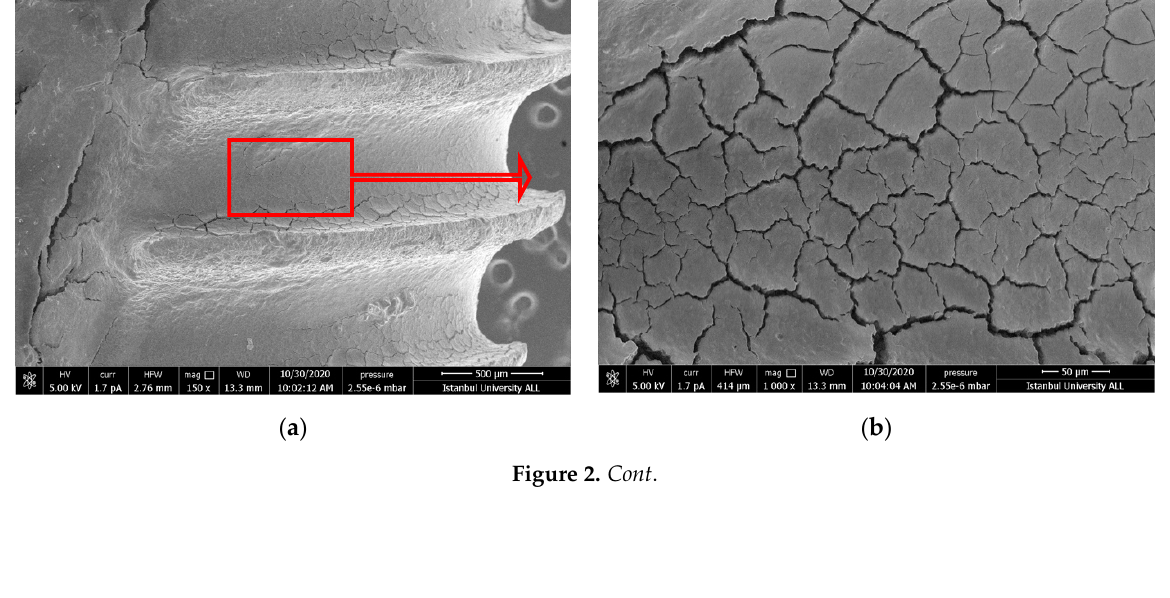
Figure 1. ( a , b ) SEM images showing the topography of untreated failed implant surfaces in Ti-Cur group (150× and 1000×) ( c , d ) after intervention (150× and 1000×). The blue arrows point to scratched areas. Red arrows show the further magnification area.